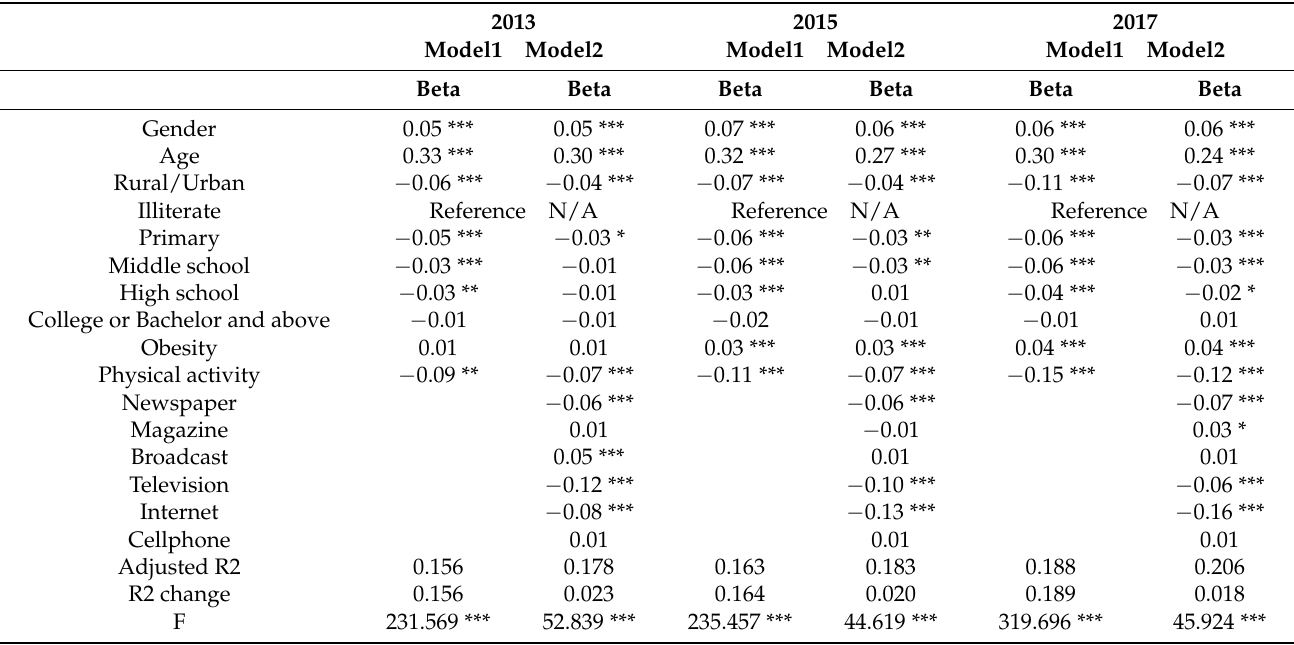
Table 4. Hierarchical multiple regression analysis of associations between media use and SHS in 2013, 2015, and 2017.